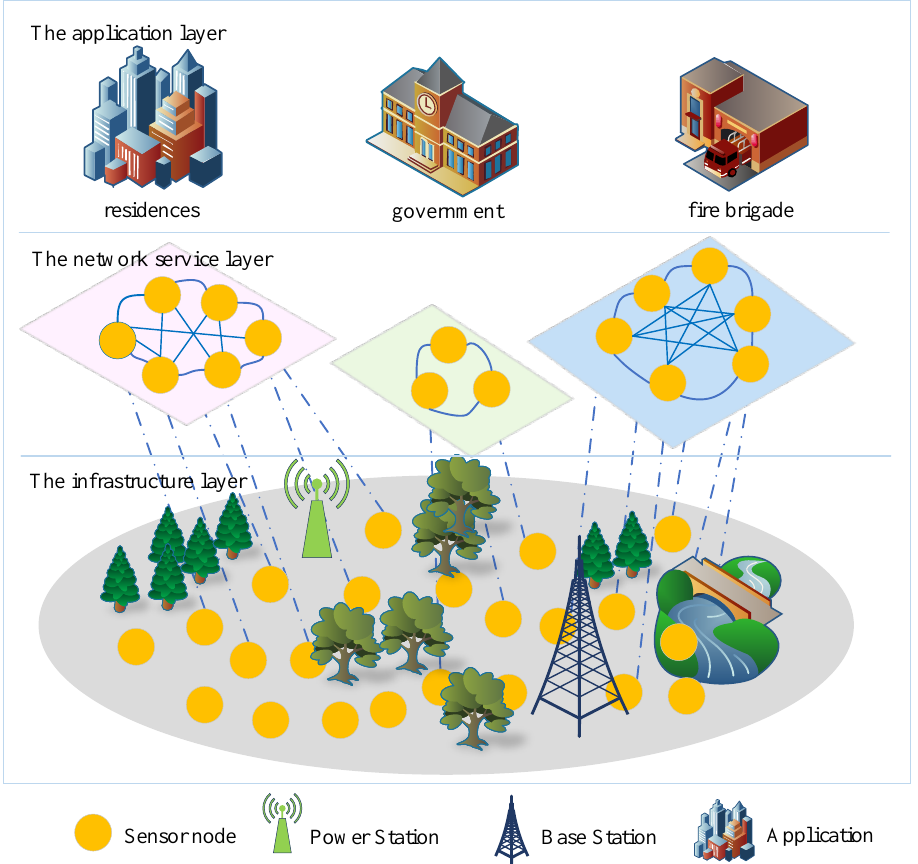
Figure 1. Network model of wireless powered virtualized sensor